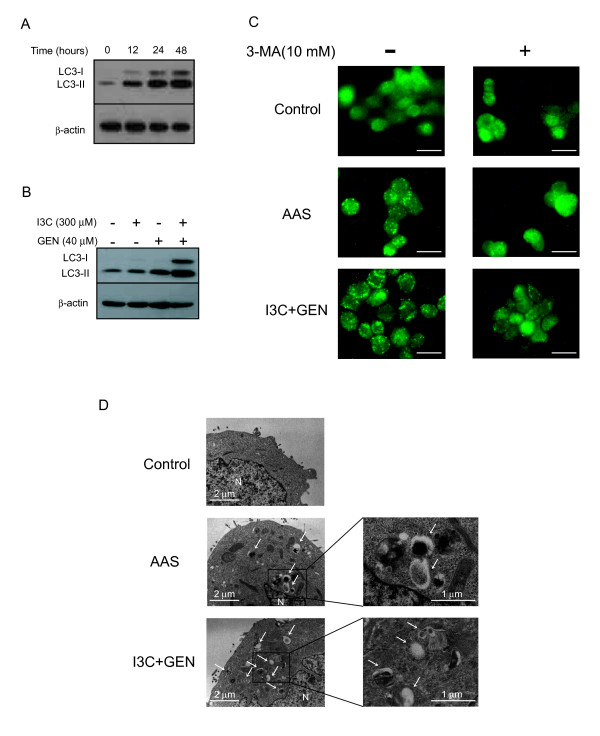
Detection of autophagosomes following co-treatment. A, After exposure to a combination of I3C (300 μmol/L) and genistein (40 μmol/L) for the periods indicated, cell lysates were subjected to western blotting with an anti-LC3 antibody. β-actin was used as a loading control. B, After exposure to the indicated agents for 48 h, cell lysates were subjected to western blotting with an anti-LC3 antibody. β-actin was used as a loading control. -, treated with DMSO: C, HT-29 cells were exposed to DMSO (control) or a combination of I3C (300 μmol/L) and genistein (40 μmol/L) for 12 h with or without 10 mmol/L of 3-methyladenine (3-MA). As a positive control for the induction of autophagy, cells were subjected to amino acid starvation (AAS) by incubating them in amino acid-deprived medium for 12 h. After the incubation, cells were subjected to immunofluorescent staining for LC3 as described in Materials and Methods. Bars, 20 μm. D, HT-29 cells were exposed to DMSO (control) or a combination of I3C (300 μmol/L) and genistein (40 μmol/L) in complete medium or subjected to AAS for 12 h. The cells were then harvested and subjected to transmission electron microscopy as described in Materials and Methods. White arrows, autophagic vesicle. N, nucleus. GEN, genistein.